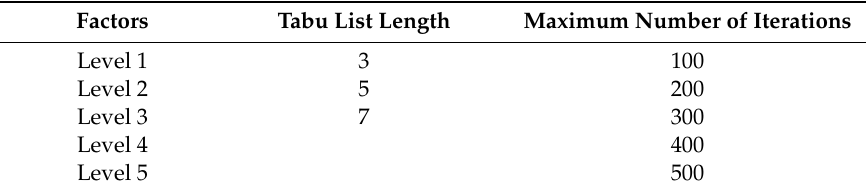
Table A1. Orthogonal factor level table of the NTS algorithm.